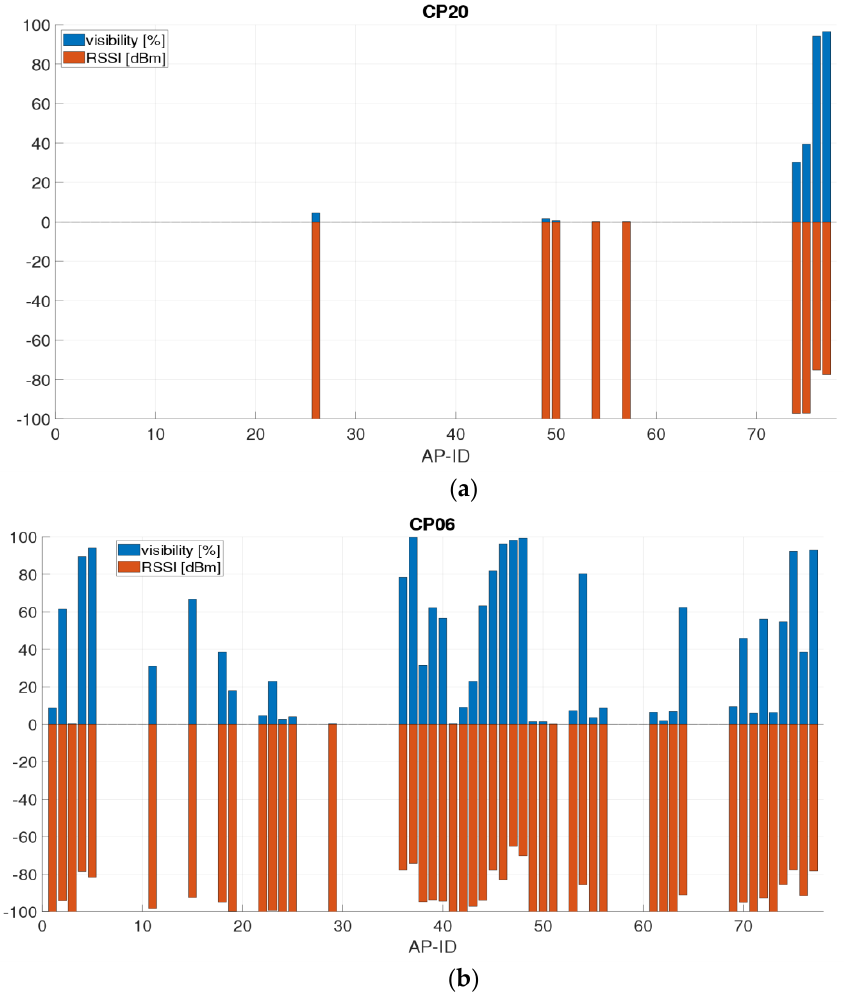
Figure 9. Checkpoints with ( a ) the lowest (CP20) and ( b ) highest (CP06) visibility. A further correlation exists between the two frequency bands 2.4 and 5 GHz that all APs provided. Across all checkpoints, the 2.4 GHz signals were on average 3.6 dBm higher than the 5 GHz signals. The average standard deviations resulted in ± 4.5 dBm for the 2.4 GHz and ± 3.5 dBm for the 5 GHz frequency band. In terms of signal range, the 2.4 GHz has a longer range from an AP compared to the 5 GHz band as it penetrates shielding materials with less loss and also has less free space path loss (FSPL), although the 5 GHz band has a 3.0 dBm higher transmitting power. The FSPL describes the reduc- tion of the power density of an electromagnetic wave in free space, i.e., without inter- ference from damping media, such as air or interference caused by reflections. As shown in [1], the attenuation thereby depends on the signal frequency and the signal weakens with increasing distance from the transmitter, also in terms of the signal-to-noise ratio. The FSPL in the unit dB is usually described on a logarithmic scale by means of the Friis transference equation [ 49 ]: 𝐹𝑆𝑃𝐿 [𝑑𝐵] = 10 ∙ 𝑙𝑜𝑔 10 (4 ∙ π ∙ 𝑑 ∙ 𝑓 c ) 2 (5) where 𝑑 is the distance between the transmitter and receiver in [m], 𝑓 is the frequency of the signals in [Hz], and 𝑐 is the propagation speed in [ms -1 ]. Thus, the power de- creases with the square of the distance to the transmitter. This applies for direct LoS signals. In practice, an empiric logarithmic distance model can be derived from Equation